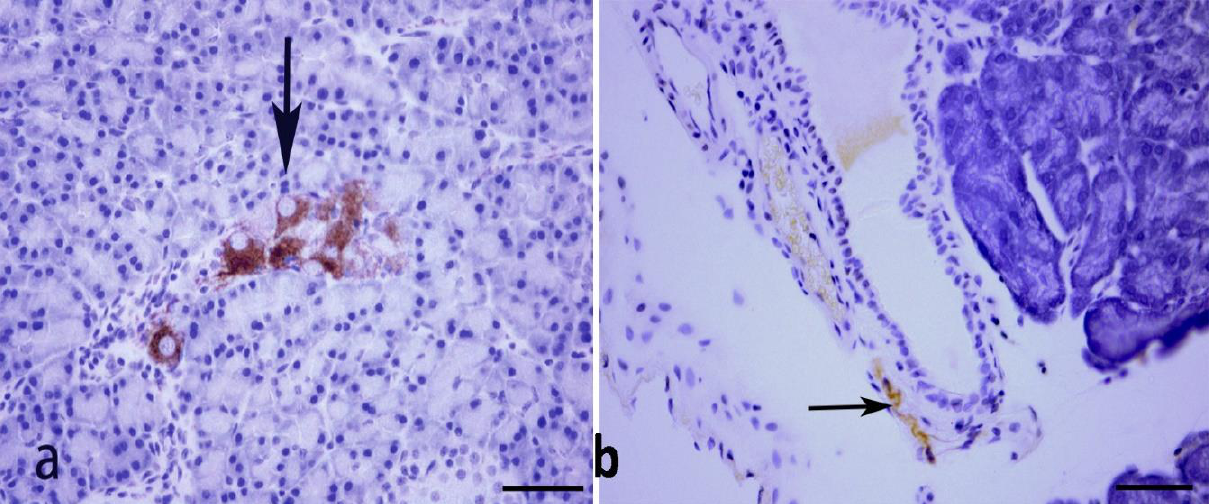
Figure 1. Shows nNOS-positive ganglion cells (thick arrow) and nerve fibres (thin arrow) in the pancreas of age-matched non-diabetic normal rat ( a ) and in pancreatic tissue fragments obtained 9 months after the onset of diabetes ( b ). nNOS-immunoreactive nerves are still present in the pancreas of diabetic rats (n = 6). Scale bar = 50 µ